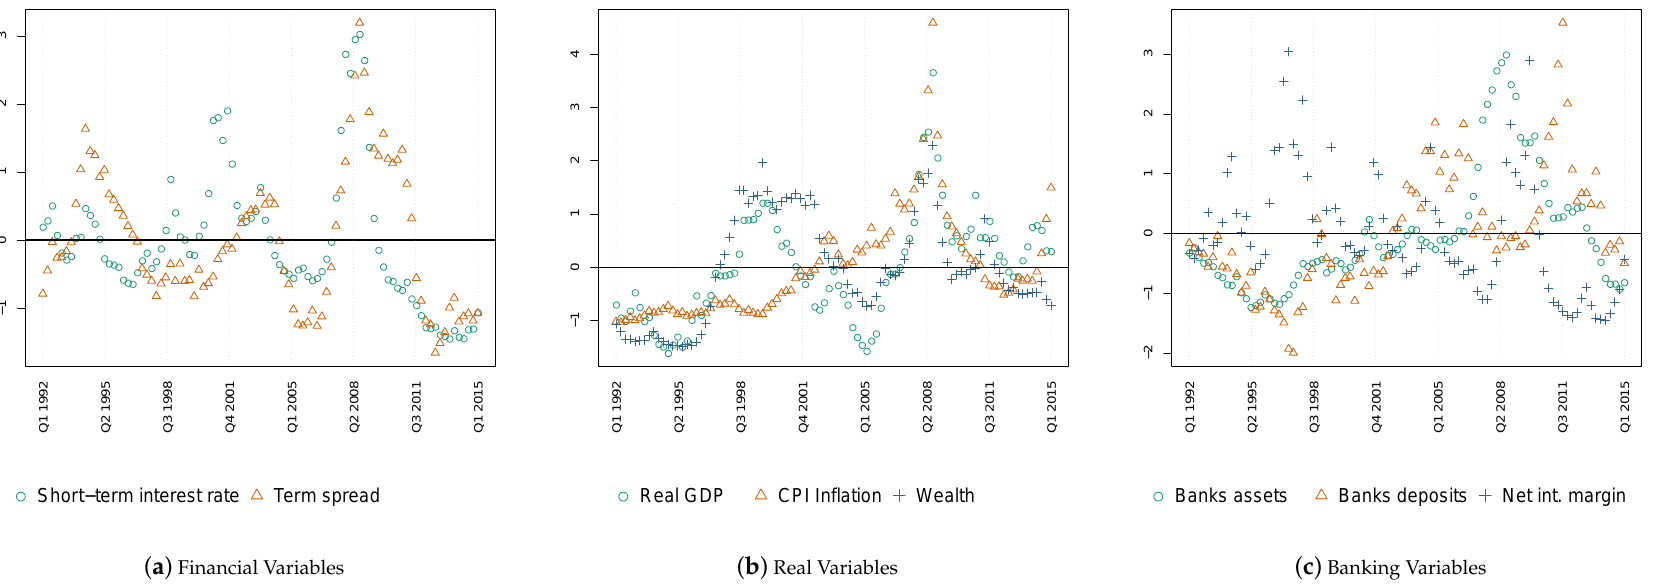
Figure A1. Stochastic volatility over time. Notes: Posterior mean of residual variance over